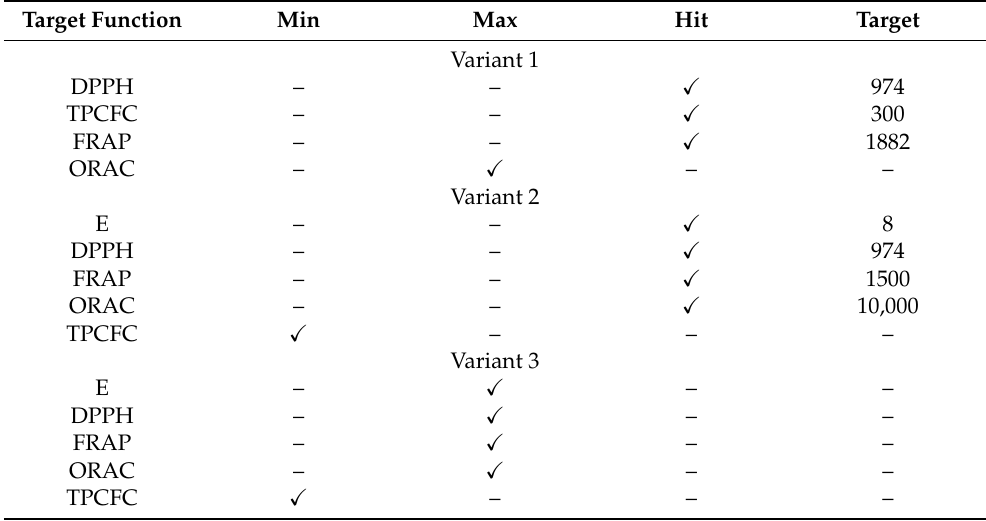
Table 3. Restriction in the different malt content and target functions for carrying out multiple response optimization of four–component